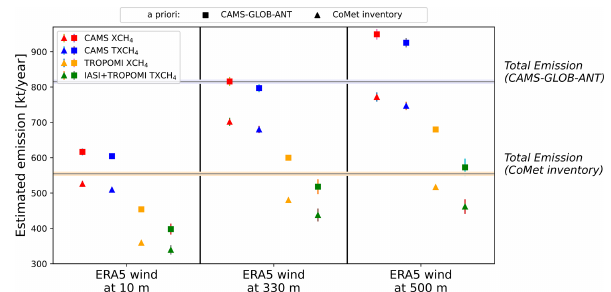
Figure 8. Estimated CH 4 emission rates derived from the CAMS forecasts (XCH 4 and TXCH 4 ), TROPOMI XCH 4 , and TROPOMI + IASI TXCH 4 data based on different a priori knowl- edge of emission sources (CAMS-GLOB-ANT and CoMet inven- tories) and on ERA5 model winds at different altitudes (10, 330, 500m). Square symbols represent the a priori emission sources from the CAMS-GLOB-ANT inventory and triangle symbols rep- resent the a priori emission sources from the CoMet inventory. The two horizontal lines represent the number of total emissions for the CAMS-GLOB-ANT inventory (lavender color) and for the CoMet inventory (orange color), respectively. Note that error bars represent the uncertainties from background removal and noise in the data, which are much smaller than the results and they are not visible here. For specific values see Table